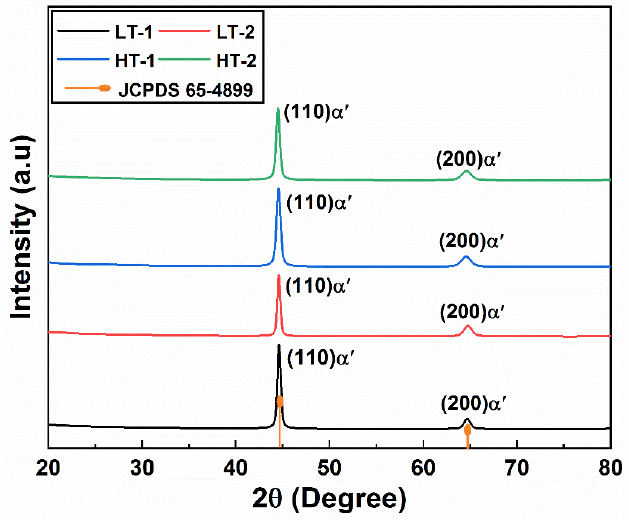
Figure 5. X-ray diffraction pattern of ballistic steel samples.